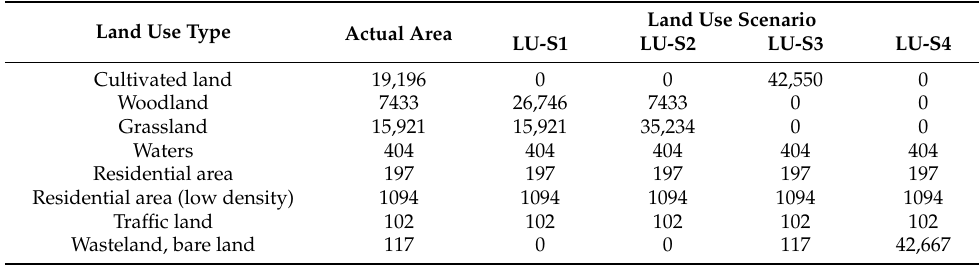
Table 1. The actual land use types of the river basin and the area distribution of land use types under scenario assumptions (hm 2